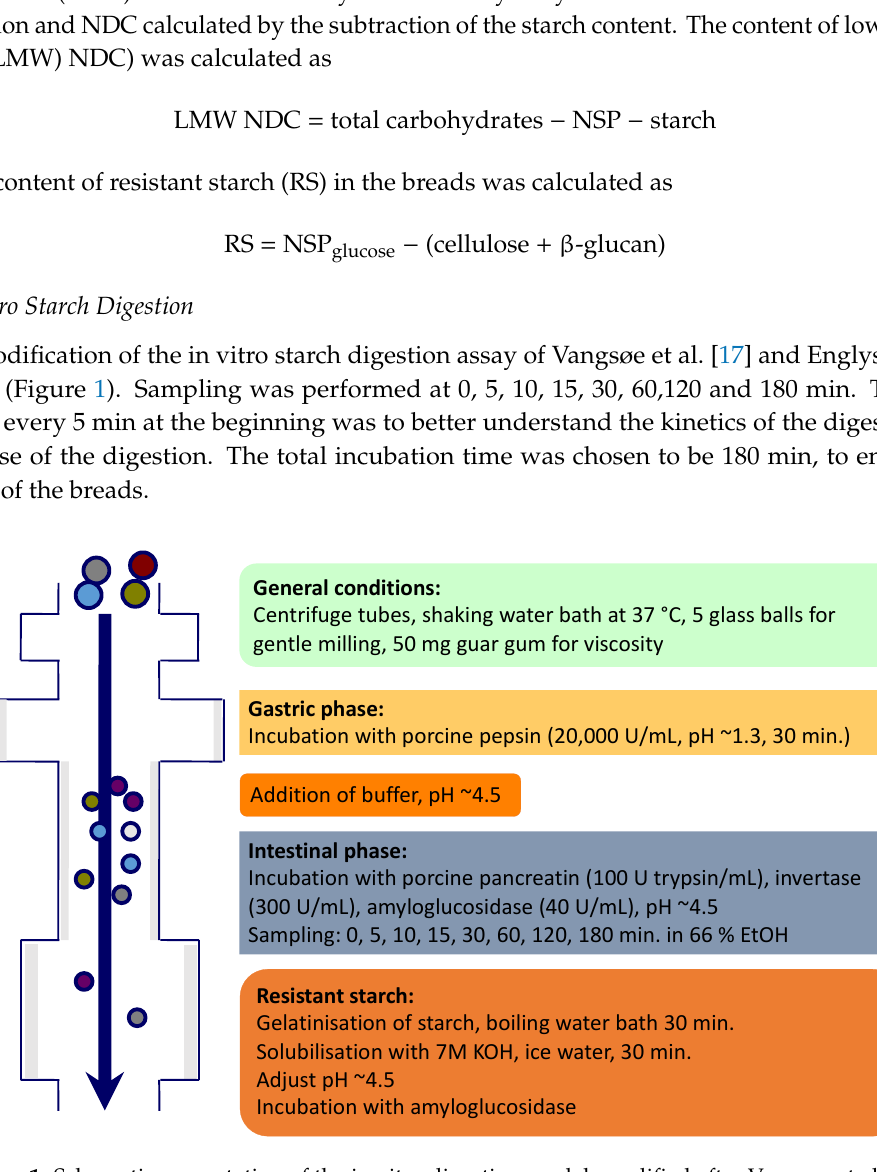
Figure 1. Schematic presentation of the in vitro digestion model, modified after Vangsøe et al. [17]. All the reactions and sample preparations were performed in Greiner 50 mL centrifuge tubes (In vitro, Fredensborg, Denmark). Before the analysis, the frozen beads (stored at −20 °C) were partially defrosted and ground (Moulinex Coffee grinder A848, Moulinex, France) for 20 s at the same speed and constant rhythm. The in vitro analyses were performed in triplicates by weighing 800 mg breads (245–360 mg of starch) into the centrifuge tubes and 50 mg guar gum (Sigma G-4129, Sigma-Aldrich, Brøndby, Denmark) to ensure similar viscosity in all the samples. Potato starch (Merck CAT No 1252,